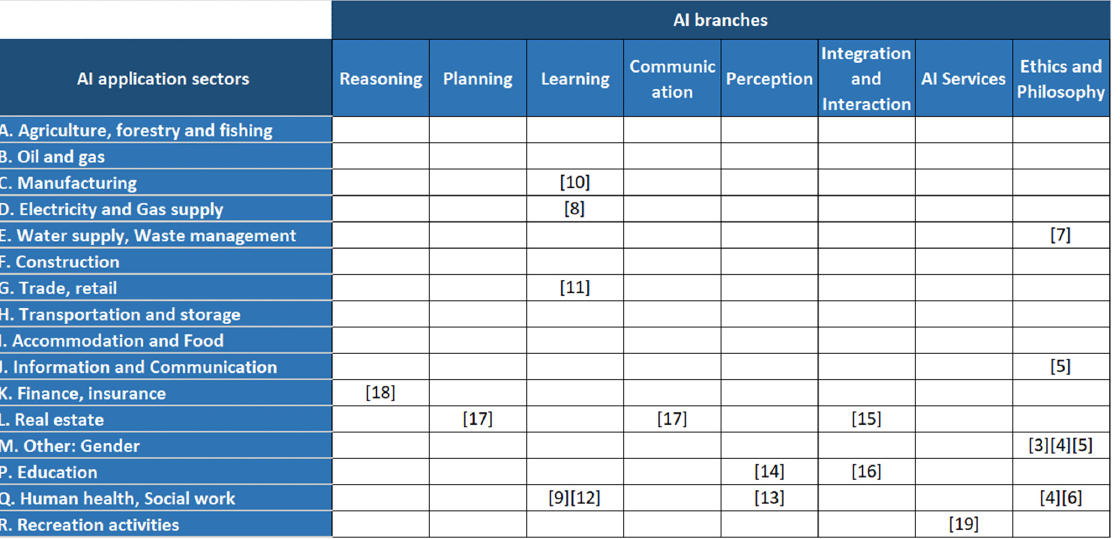
Figure 4. Distribution of the papers according to the number of authors ( left ); Distribution of the papers according to the number of female authors ( right ). In Figure 5, it can be seen that the number of female authors slightly increases with the total number of authors, but the most frequent situation is to have 2 female authors (with 10 papers), and often they work alone (4 papers with a total of 2 authors, all female).